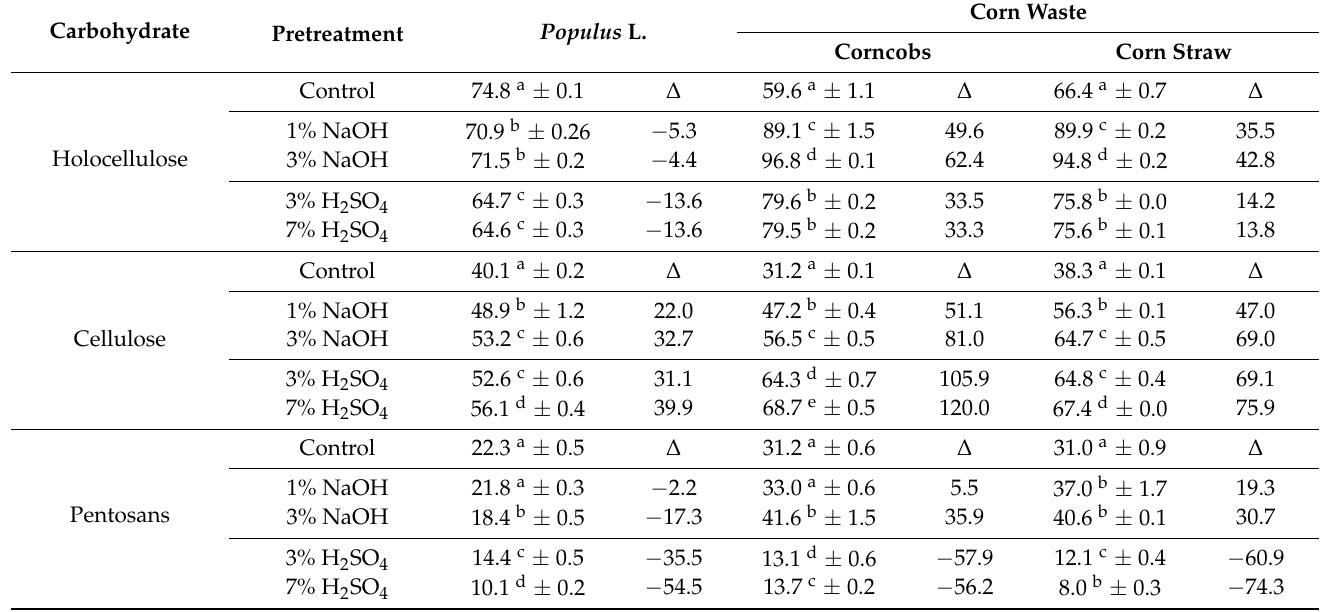
Table 1. Percentage shares of carbohydrate compounds in Populus L. and corn waste before and after